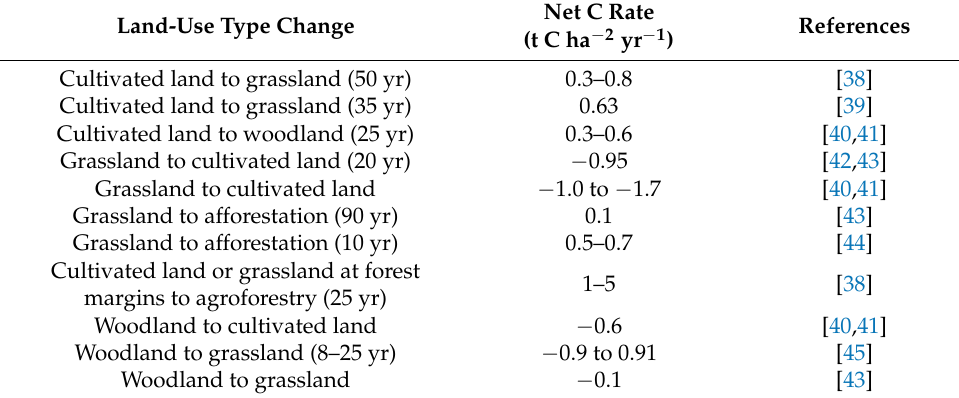
Table 4. Changes in soil carbon sequestration under land-use type